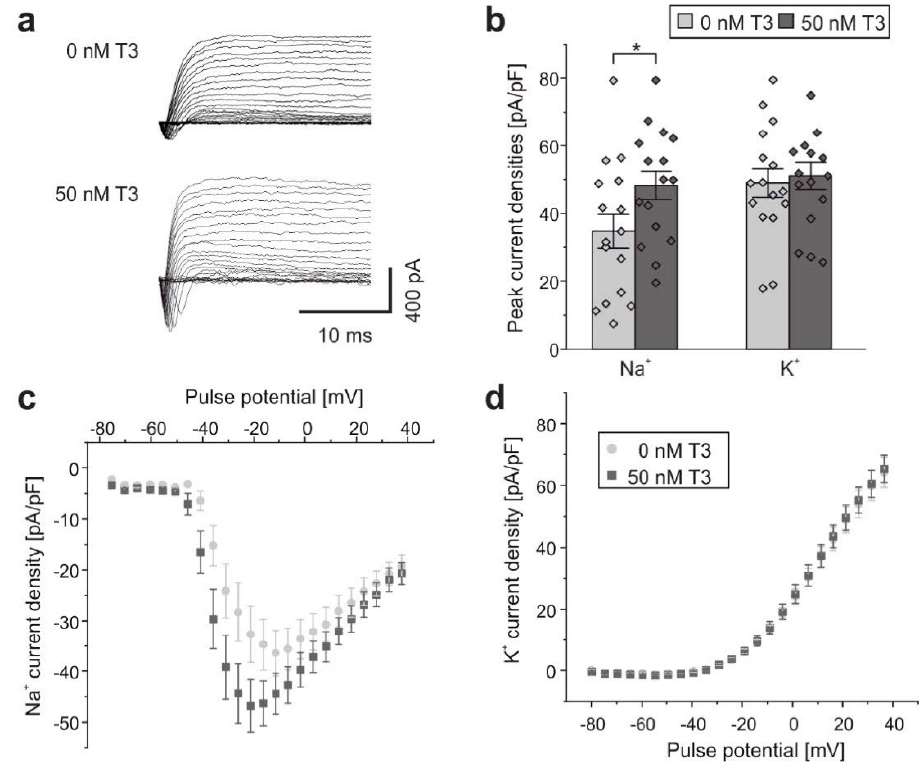
Figure 1. Effects of T3 on Na + and K + currents in cultured mouse hippocampal neurons. ( a ) Series of original Na + and K + current recordings from cultured Pax8 +/+ , Pax8 +/ − mouse hippocampal neurons evoked by step depolarizations in 5 mV increments starting from a holding potential of − 80 mV (after liquid junction correction). Top: current traces from untreated neurons. Bottom: traces from neurons after treatment with 50 nM T3 for 4 days. ( b ) Peak Na + and K + currents normalized to membrane capacitance. Bars represent means ± SEM. Single data points shown as diamonds. Average current to voltage (I/V) relationships for ( c ) Na + currents and ( d ) K + currents normalized to membrane capacitance recorded from neurons cultured in presence or absence of 50 nM T3. Data points represent means ± SEM. Statistically significant differences marked by * ( p < 0.05). Recordings from 16 neurons for each condition from two independent